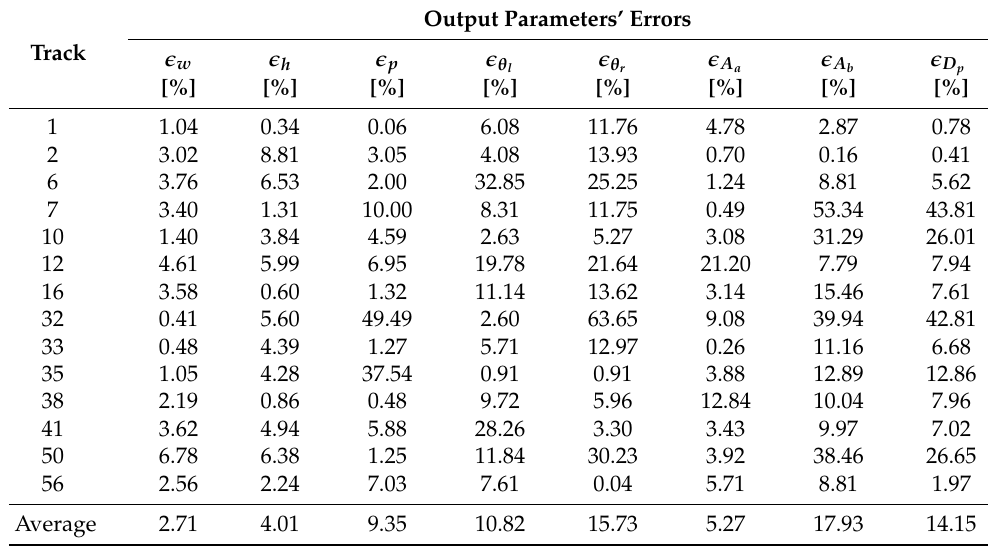
Table 6. Percentage errors between the manually measured and algorithm-computed output